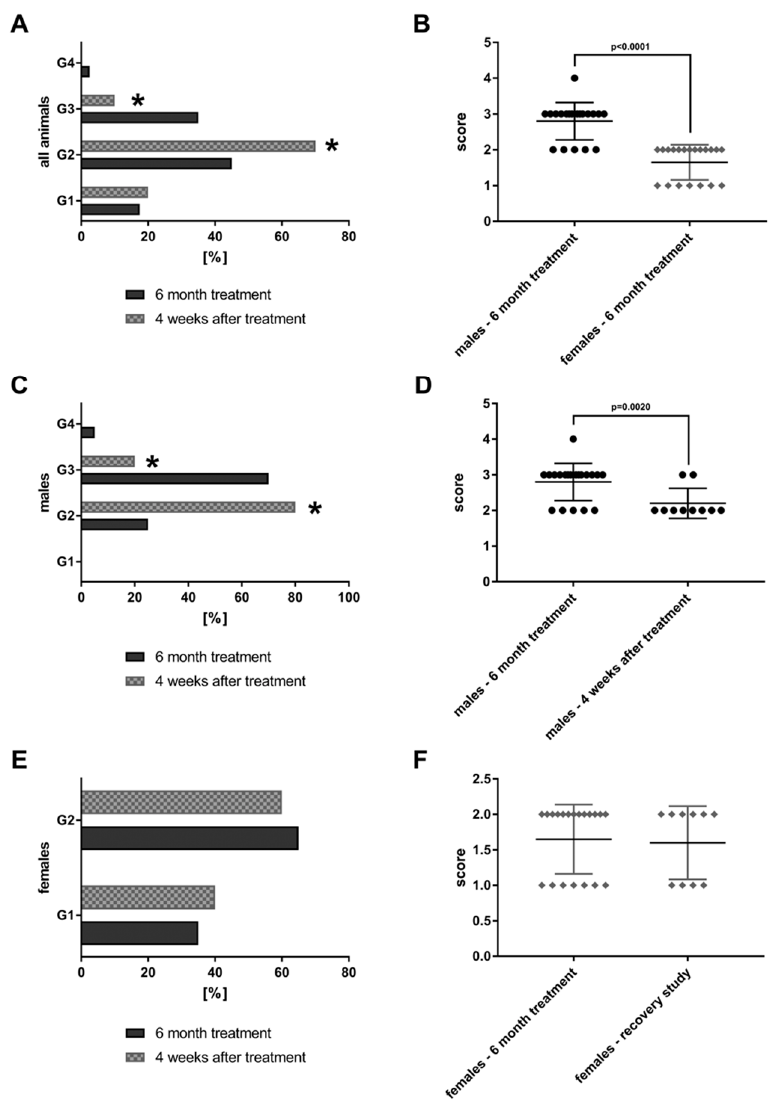
Figure 2. Bile duct proliferations after repeated oral dosing of rats with a Petasites hybridus extract (Petadolex) for six months and a recovery period of four weeks. Bile duct proliferations were dosage related with both sex. The grading of lesions ranges from minimal (G1), mild (G2), moderate (G3) to marked (G4). ( A ) Grading of bile duct proliferations of 40 high dose animals (dark column) and 20 recovery animals (grey patterned) treated for 6 month. Using the Fischer exact test, a statistically significant reduction from moderate (G3) to mild (G2) was calculated for animals which were allowed to recover from the treatment for four weeks ( p = 0.0001). ( B ) The scores for male female animals after repeated treatment for six months are compared. Males are more sensitive to the treatment e ff ects as determined by the Wilcoxon-Mann-Whitney-Test. ( C ) Grading of bile duct proliferations of 20 high dose males (dark column) and 10 male recovery animals (grey patterned) treated for six months. Using the Fischer exact test, a statistically significant reduction from moderate (G3) to mild (G2) was calculated for animals that were allowed to recover from the treatment for four weeks ( p = 0.0161). ( D ) The scores for male animals after repeated treatment for six months and male recovery animals are compared. The grades of lesion di ff ered significantly as determined by the Wilcoxon-Mann-Whitney-Test. ( E ) Grading of bile duct proliferations of 20 high dose females (dark column) and 10 female recovery animals (grey patterned) treated for six months. There was no di ff erence between the groups, albeit the lesions are less pronounced when compared to males. ( F ) The scores for female animals after repeated treatment for six months and female recovery animals. There was no di ff erence between the